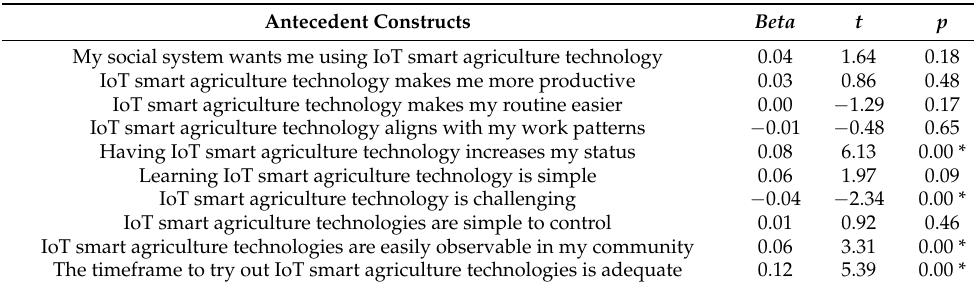
Table 11. IoT Smart Agriculture Adoption Attributes. Antecedent